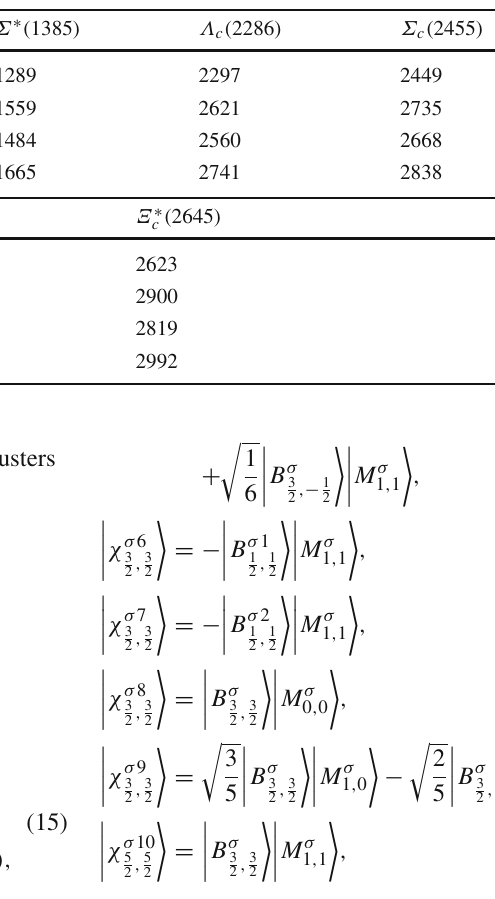
Table 3 The masses of ground-state and low-lying exited state baryons (unit: